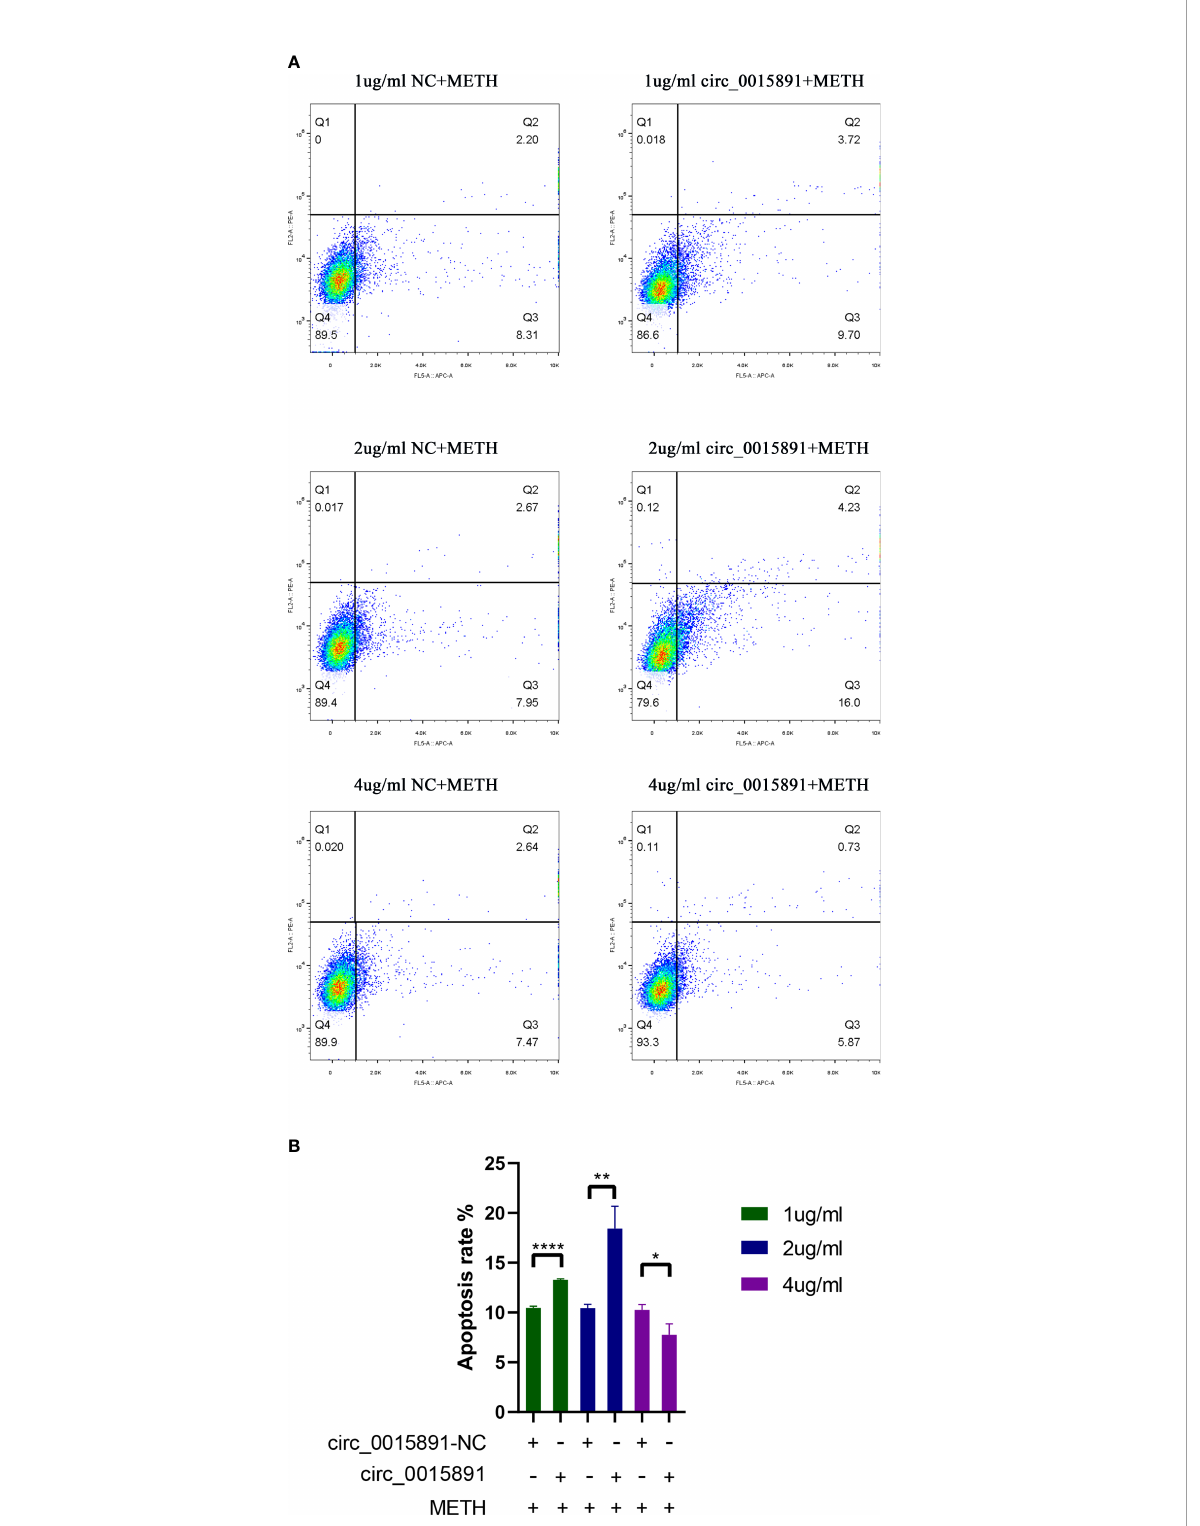
FIGURE 5 Effect of circ_0015891 in METH-induced dopaminergic apoptosis. (A) and (B) Effects of circ_0015891 on apoptosis in different concentrations. The apoptosis rate = percentage of early apoptosis (Q3) + percentage of late apoptosis (Q2). Signi fi cant differences are indicated by asterisks. Error bars represent the mean ± SEM. *P<0.05; **P<0.01;